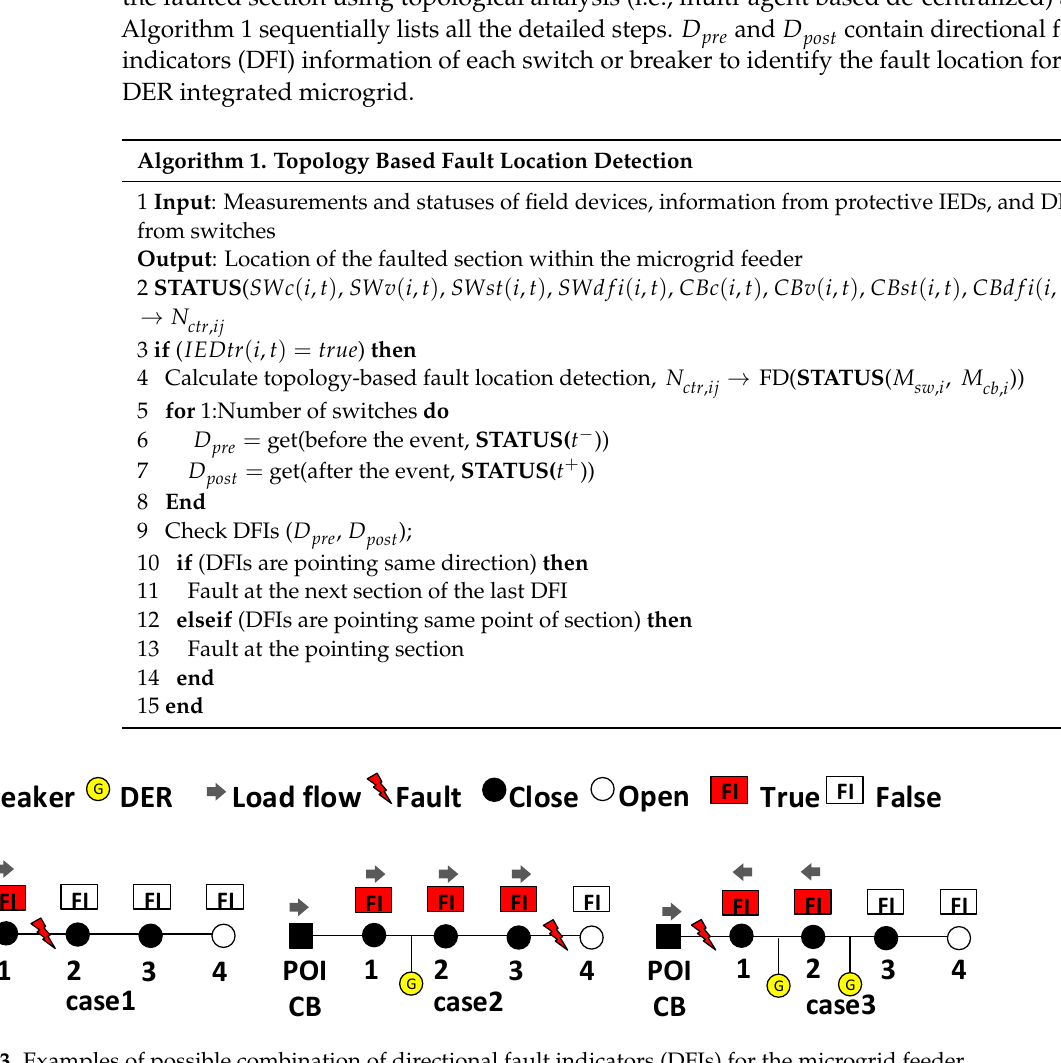
Figure 3. Examples of possible combination of directional fault indicators (DFIs) for the microgrid feeder.